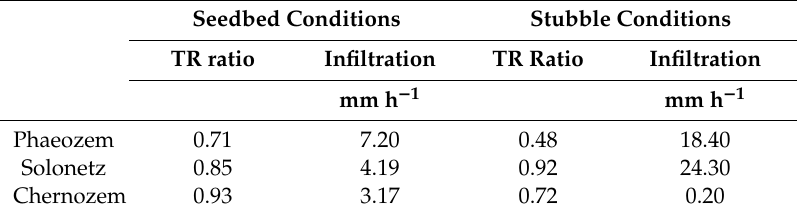
Table 4. Ratio of topographical range values after / before precipitation and final infiltration